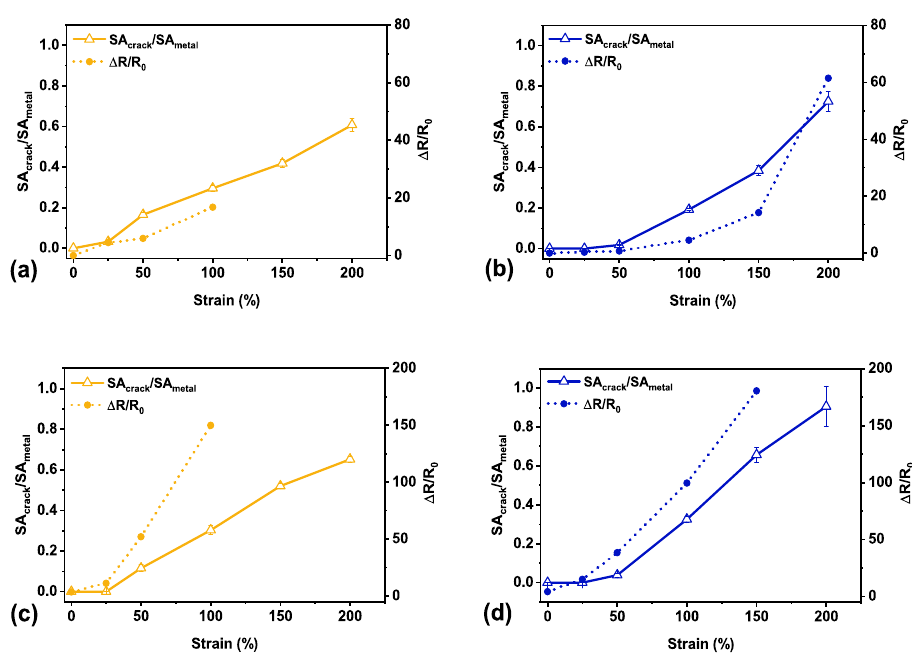
Figure 8. Electrical performance as related to crack evolution (SA crack /SA metal ) for the best performing unencapsulated sensor, pre-fracture ( a ) and post-fracture ( c ). Electrical performance related to crack evolution for the best performing encapsulated sensor, pre-fracture ( b ) and post-fracture ( d ). Error bars on crack evolution data depict standard deviation across three separate images whereas there is only one viable measurement for electrical resistance on each sensor.